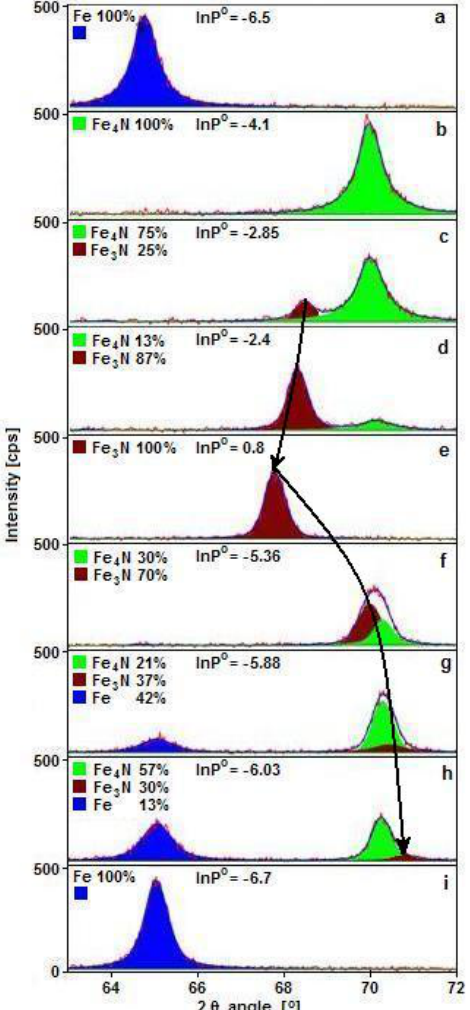
Figure 1. Exemplary diffractograms obtained in nitriding ( a – e ) and reduction ( e – i ) processes. One can observe that the ε Fe 3-2 N(300) diffraction reflex, brown in color in Figure 1, moved 2 θ in angle position from 67.76 ◦ (Figure 1e) to 71 ◦ (Figure 1h) in extreme cases. Based on this shift, the interplanar distance of ε phase, d ε , was calculated and shown